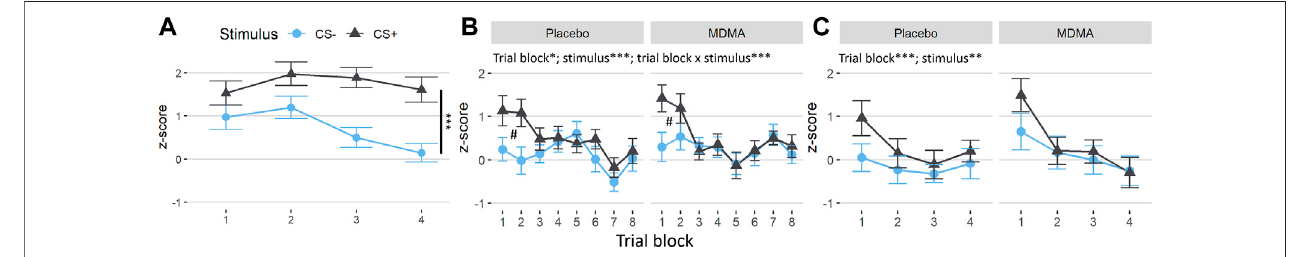
FIGURE 4 | No changes induced by MDMA in the fear-potentiated startle task. Difference between the standardized values of both conditioned trial types (conditioned fear stimulus [CS+] and conditioned safety stimulus [CS − ]) and the pulse alone (NA) during the fear-potentiated startle task. (A) Subjects showed a clear differentiation between CS+ and CS − in acquisition. (B) In the extinction learning phase, subjects in both sessions displayed discrimination of the conditioned stimuli in the early trial blocks ( # CS+ vs. CS − of block 1 and 2, Tukey posthoc: p < 0.001 and p < 0.01, respectively) and extinction over time (trial blocks). (C) In the recall extinction phase, subjects in both sessions showed a return of fear of the conditioned stimulus in the early trial blocks and renewed extinction over time. The acquisition was before drug intake. MDMA, 3,4-methylenedioxymethamphetamine. Values are mean ± SEM. Stats in (A) are main effects. * p < 0.05, ** p < 0.01, *** p <